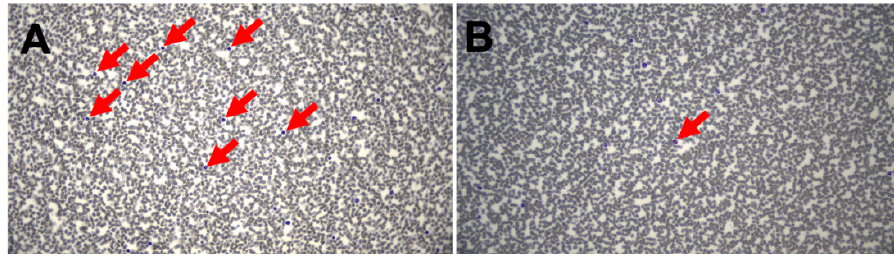
Figure 1. Representative images of patients with ( A ) higher and ( B ) lower number of eosinophils in blood smears (original magnification 400×).